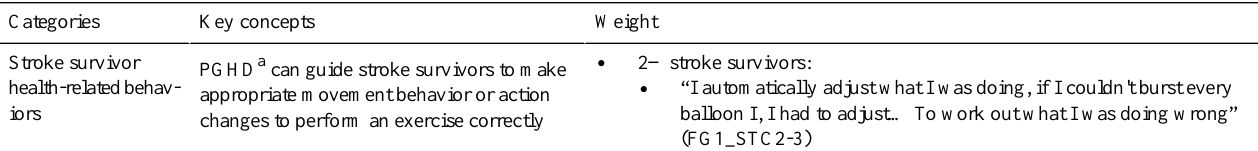
Table 1. Weighted key concepts identified from step 1: exploratory